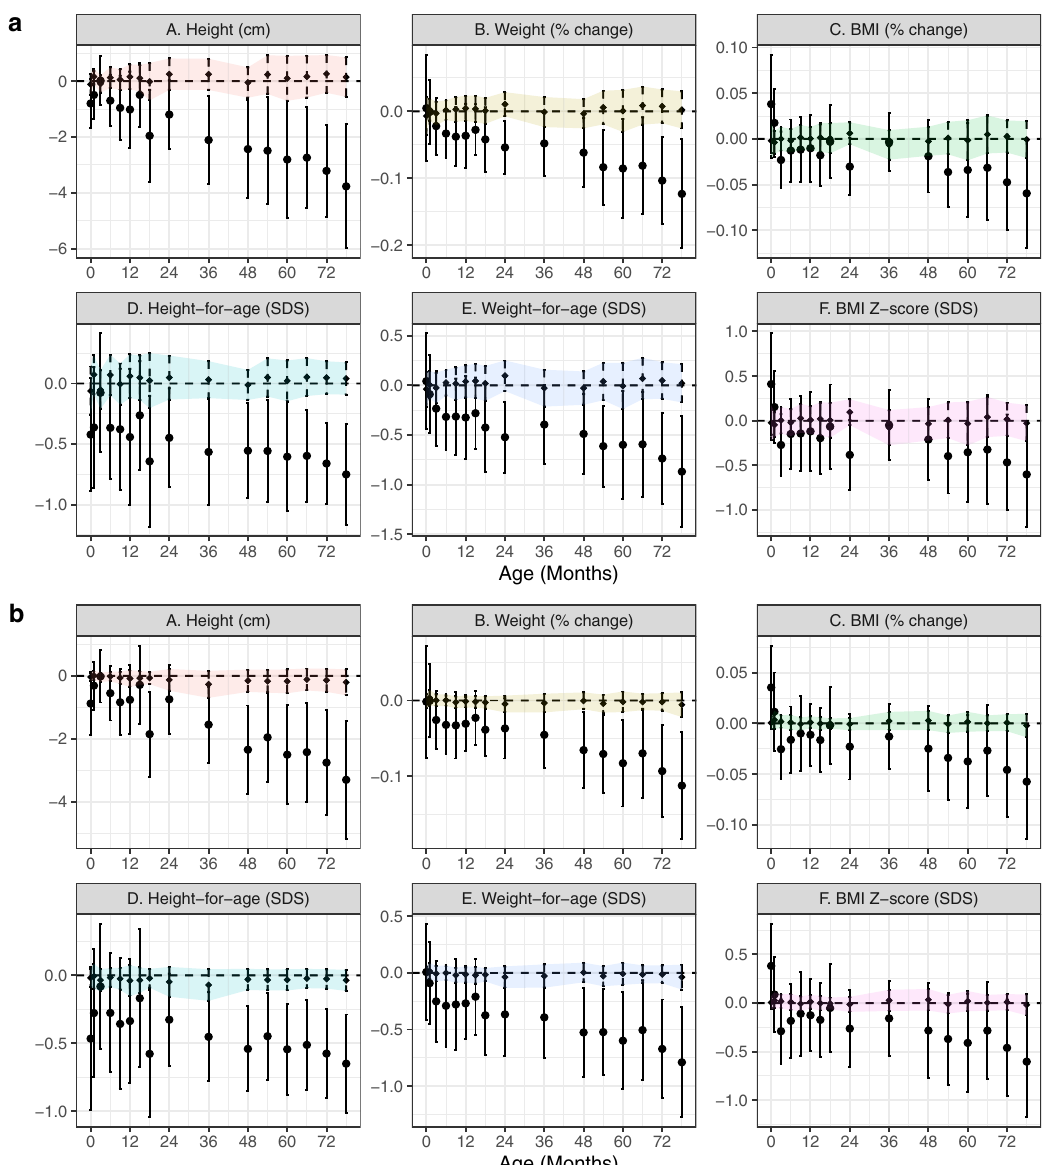
Fig. 6 Monte Carlo-simulated effects of ART mediated through fetal cord tissue methylation, target trial. The solid lines show the estimates and Wald- type 95% con fi dence intervals for the hypothetical average direct treatment effect of assigning all subjects to ART (versus spontaneous conception) while holding methylation for ( a ) cg03904042 ( NECAB3 ) or ( b ) cg27146050 ( HIF3A ) at the untreated (SC) level, in an emulated pragmatic trial among subfertile couples. Point estimates and standard errors were estimated by parametric g-computation in 100 bootstrapped datasets. Analyses are similar to those in the overall cohort but restricted to pregnancies from ART ( N = 83) and spontaneous conceiving couples with infertility indications ( N = 93). Sample sizes across visits are identical to Fig. 3a. cm centimeters, SDS standard deviation score; colors used to distinguish outcome measures. Shaded regions connect con fi dence intervals to aid in visualizing trends and provide no additional information regarding estimates between